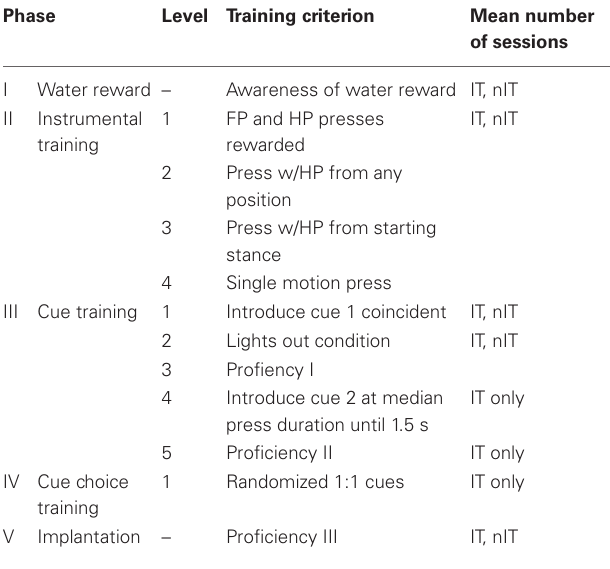
Table 1 | Training schedule for skilled hindlimb press